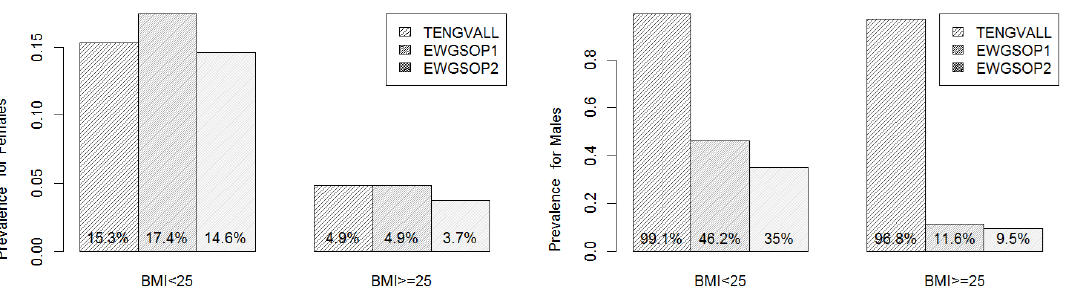
Figure 3. The prevalence of low ASMI under each diagnostic criterion which was calculated over BMI categories and for males and females separately.